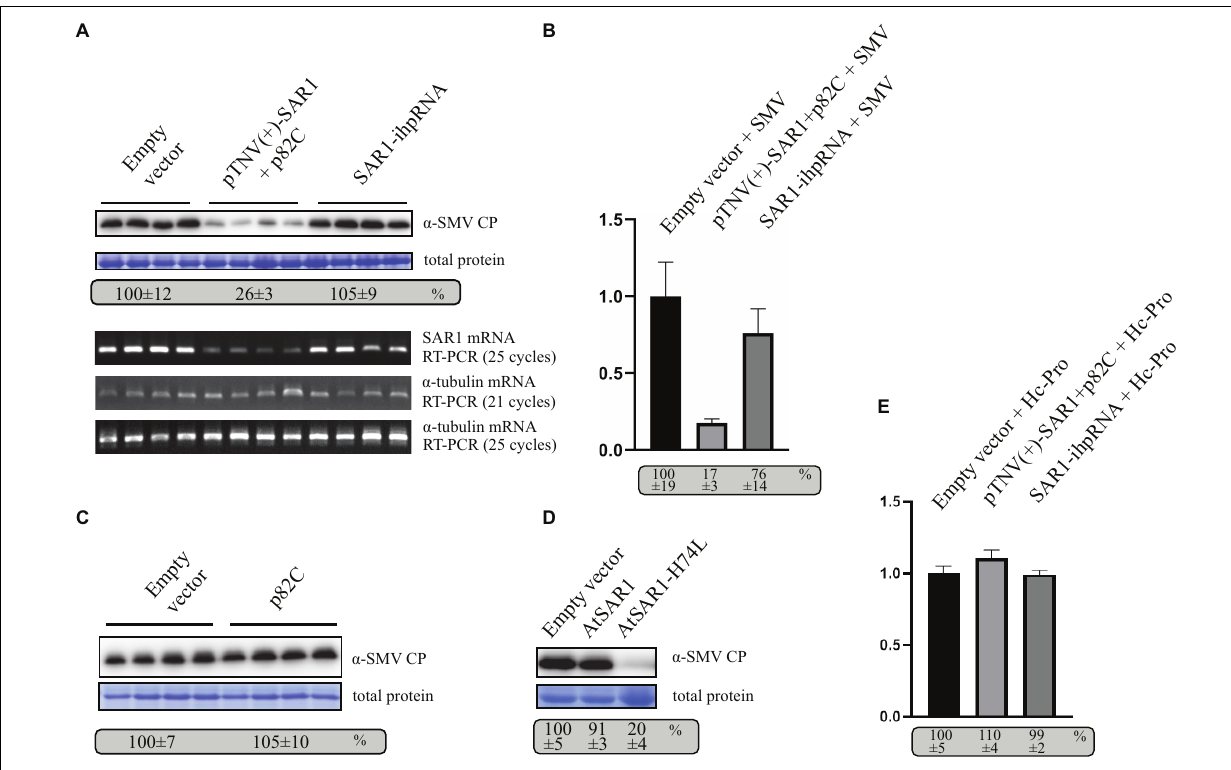
FIGURE 4 | VARS system-induced SAR1 silencing inhibits SMV replication. (A) SMV accumulation in leaf samples infiltrated with empty vector [pCB301-314-pTNV(+)-RZ] (OD 600 of 0.8) or samples silenced for SAR1 by VRAS vectors (OD 600 of 0.4, each) or by ihpRNA-expressing vector (OD 600 of 0.8) in the presence of SMV infectious clone (OD 600 of 0.2) was measured by Western blotting at 5 dpi. Total protein loadings were shown as Coomassie blue-stained gel (upper panels). Semiquantitative PCR analysis was performed to measure the mRNA levels of SAR1 or α -tubulin coding gene in the SMV-infected leaves 5 days after viral infection. The number of PCR cycles is shown by each gel (lower panels). (B) qPCR measuring SAR1 mRNA accumulation. The SAR1 mRNA level from empty vector infiltrated leaf samples was set as 100%. Standard error was calculated from three independent repeats. See more details in panel (A) . (C) SMV accumulation in leaf samples infected with SMV infectious clone (OD 600 of 0.2) and coexpressed with p82C (OD 600 of 0.8) was measured by Western blotting at 5 dpi. Total protein loadings were shown as Coomassie blue-stained gel. (D) SMV accumulation in leaf samples infected with SMV infectious clone (OD 600 of 0.2) and coexpressed with wt AtSAR1 or AtSAR1-H74L dominant-negative mutant (OD 600 of 0.2) was measured by Western blotting at 5 dpi. Total protein loadings were shown as Coomassie blue-stained gel. (E) qPCR measuring SAR1 mRNA accumulation in leaf samples infiltrated with empty vector [pCB301-314-pTNV(+)-RZ] (OD 600 of 0.8) or VRAS vectors for SAR1 silencing (OD 600 of 0.4, each) or ihpRNA-expressing vector (OD 600 of 0.8) in the presence of SMV Hc-Pro expression (OD 600 of 0.2) at 5 dpi. The SAR1 mRNA level from empty vector and Hc-Pro-infiltrated leaf samples was set as 100%. Standard error was calculated from three independent